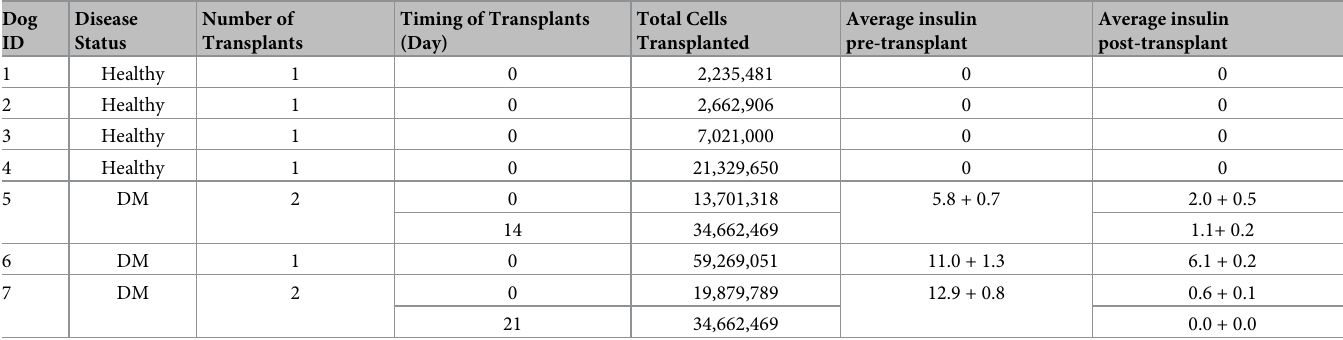
Table 4. Insulin utilization.